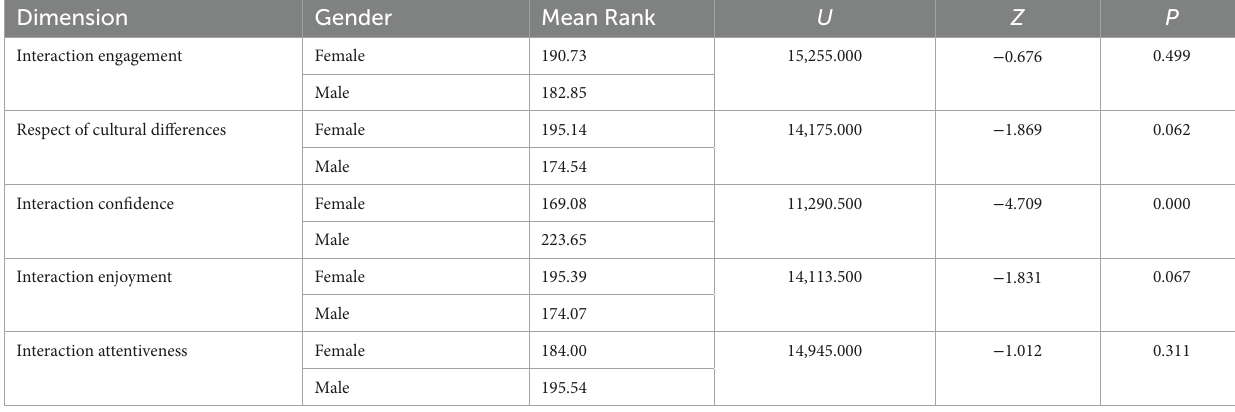
TABLE 4 Mann–Whitney U test for different dimensions according to gender.